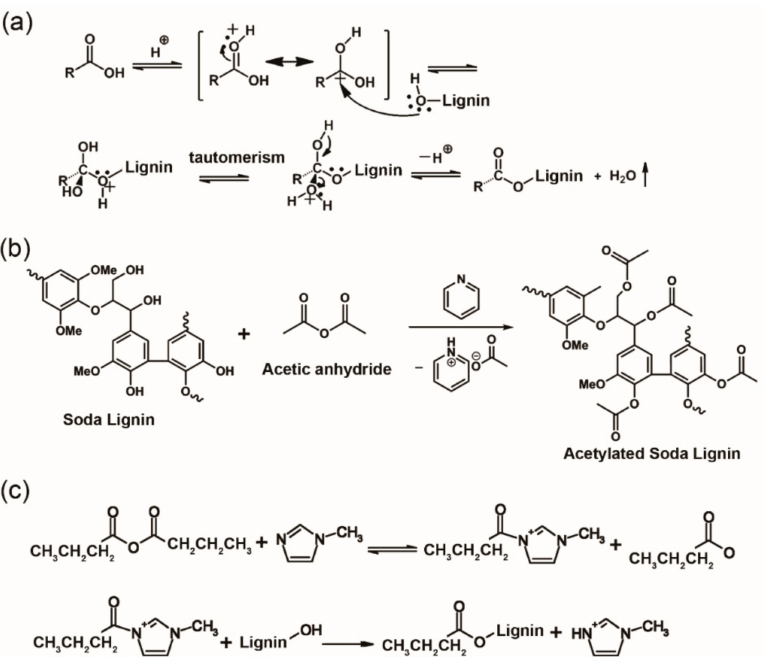
Figure 4. The chemical reaction mechanisms of ( a ) direct esterification, ( b ) acetylation, and ( c ) bu- tyration of lignin. ( a ) Reproduced with permission from [109], copyright 2019 Royal Society of Chemistry. ( b ) Reproduced with permission from [110], copyright 2016 American Chemical Society. ( c ) Reproduced with permission from [93], copyright 2005 American Chemical